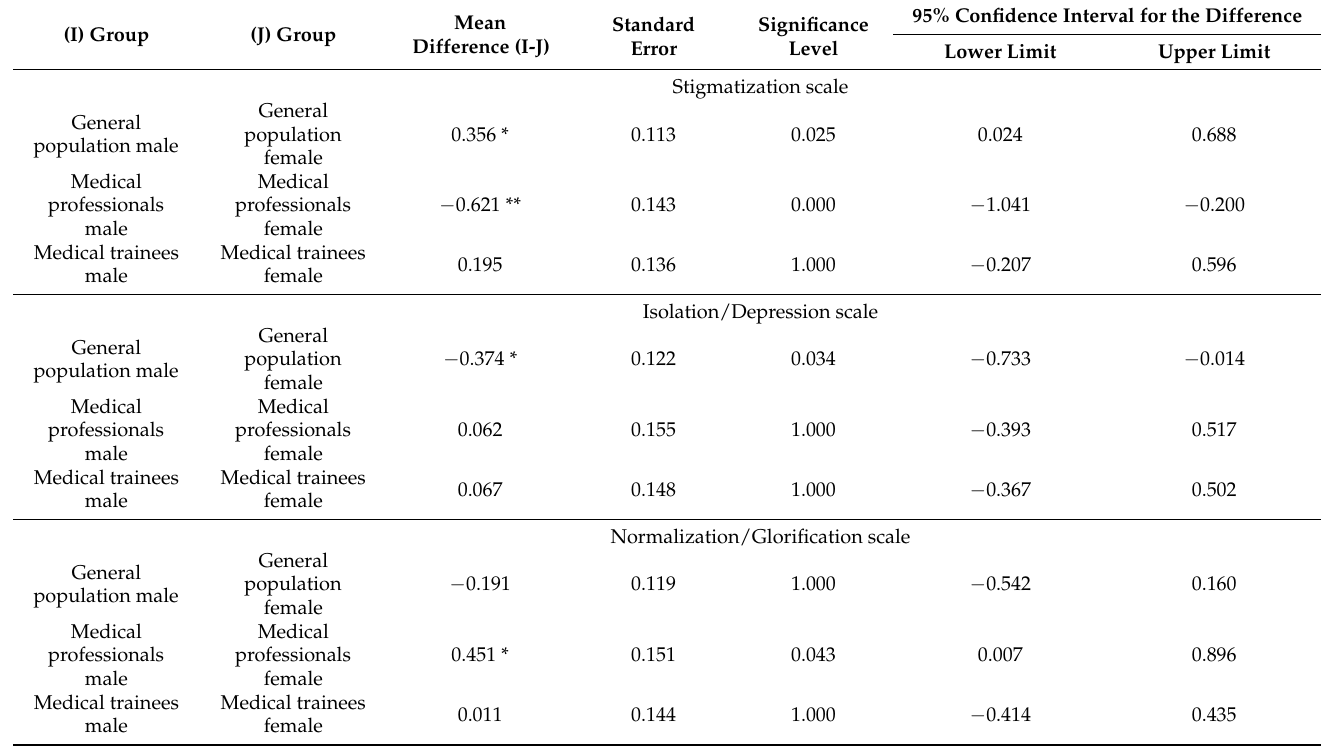
Table 4. Results of the pairwise comparisons according to the Bonferroni test of the two gender groups of the three study groups (post hoc of the MANCOVA) with regard to the sum scores for the “stigmatization”, “isolation/depression” and “normalization/glorification” scales of the SOSS.